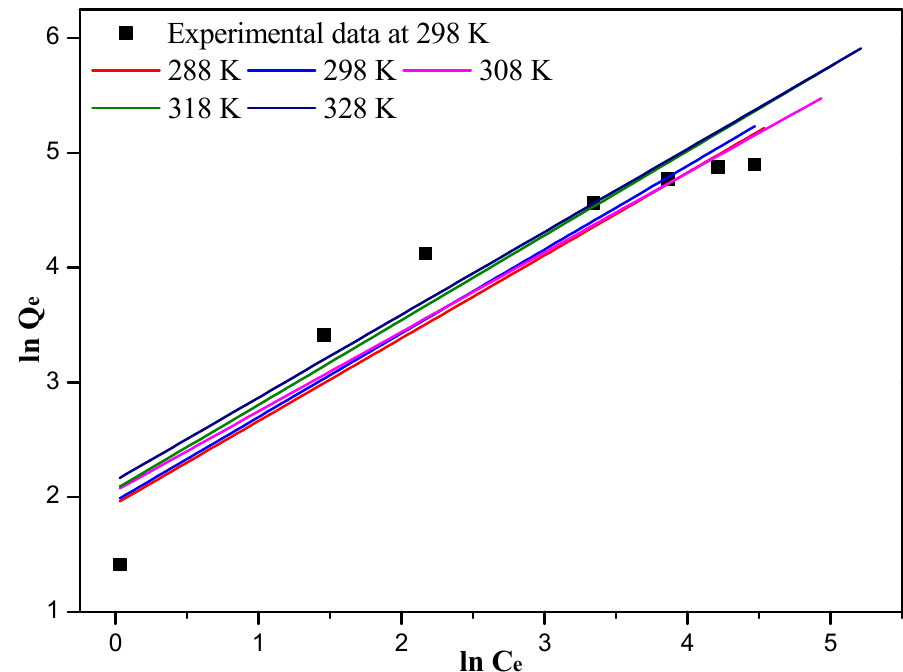
Figure 7. Experimental data at 298 K and Freundlich isotherm plots for the adsorption of Cr(VI) ions at different temperatures.